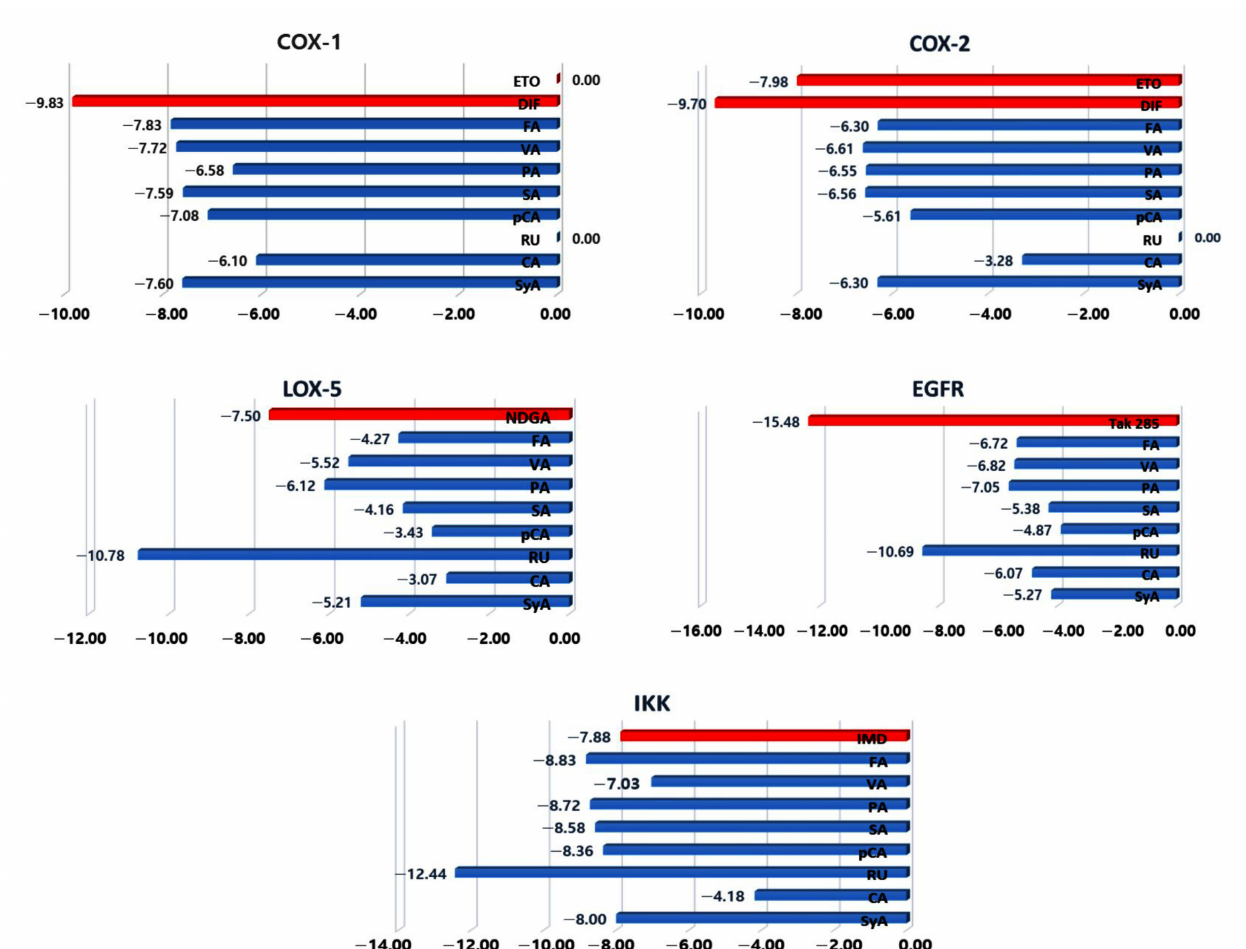
Figure 4. Docking score chart for selected compounds with each target. All the scores were transformed into positive values to create the chart. A value of 0.00 denotes no successful docking pose generated with the target active site. Red bars indicate the docking scores of the control compounds to the corresponding